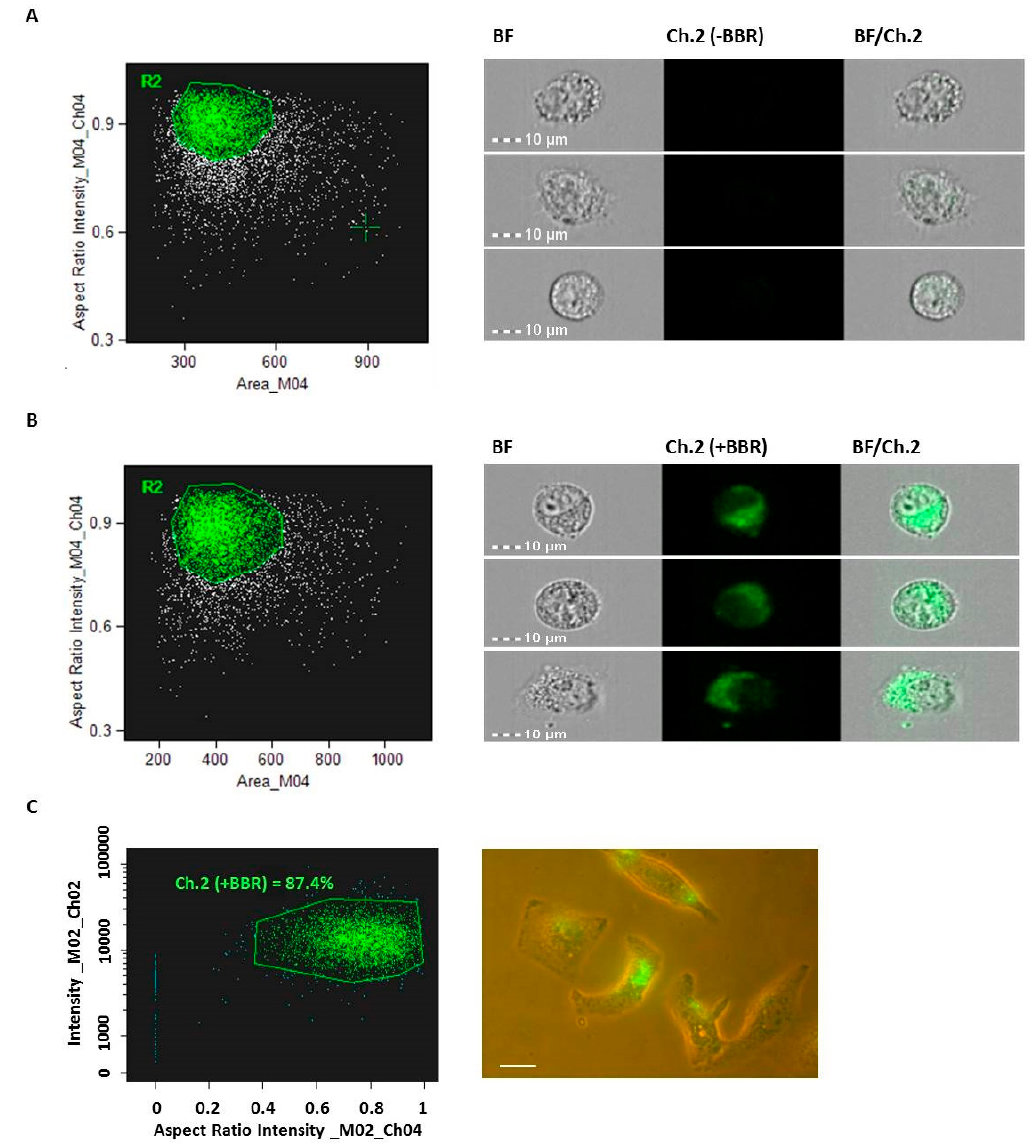
Figure 8. Amnis ImageStreamX MarkII flow cytometry analysis of T98× cells (R2 gates = 5000 single cells each) after administration of plasma membranes generated nanovesicles (M-NVs) ( A ) or with Berberine (BBR) encapsulated M-NVs, visualized in Brightfield (BF) and Ch.2 fluorescent channels (40×) ( B ). The percentage of BBR-positive M-NVs were evaluated by flow cytometry (i.e., 87.4% of R2 gated cells, C left panel); these M-NVs were then administered overnight to growing T98G cells and observed using Nikon Eclipse TS100 inverted fluorescent microscope ( C , right panel) (40×, scale bar = 10 μ m).